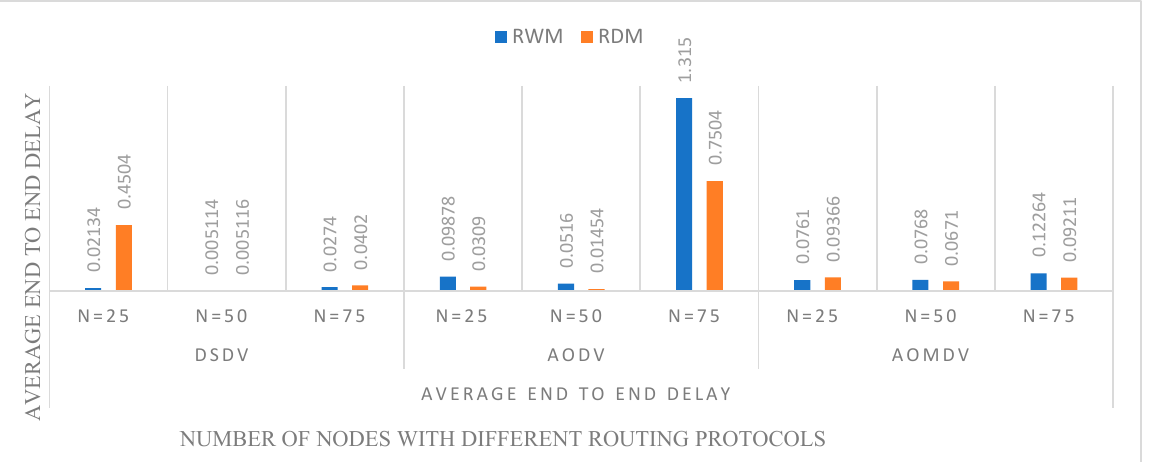
Figure 5. Performance analysis of RWM and RDM on various routing protocols in terms of average end-to-end delay.